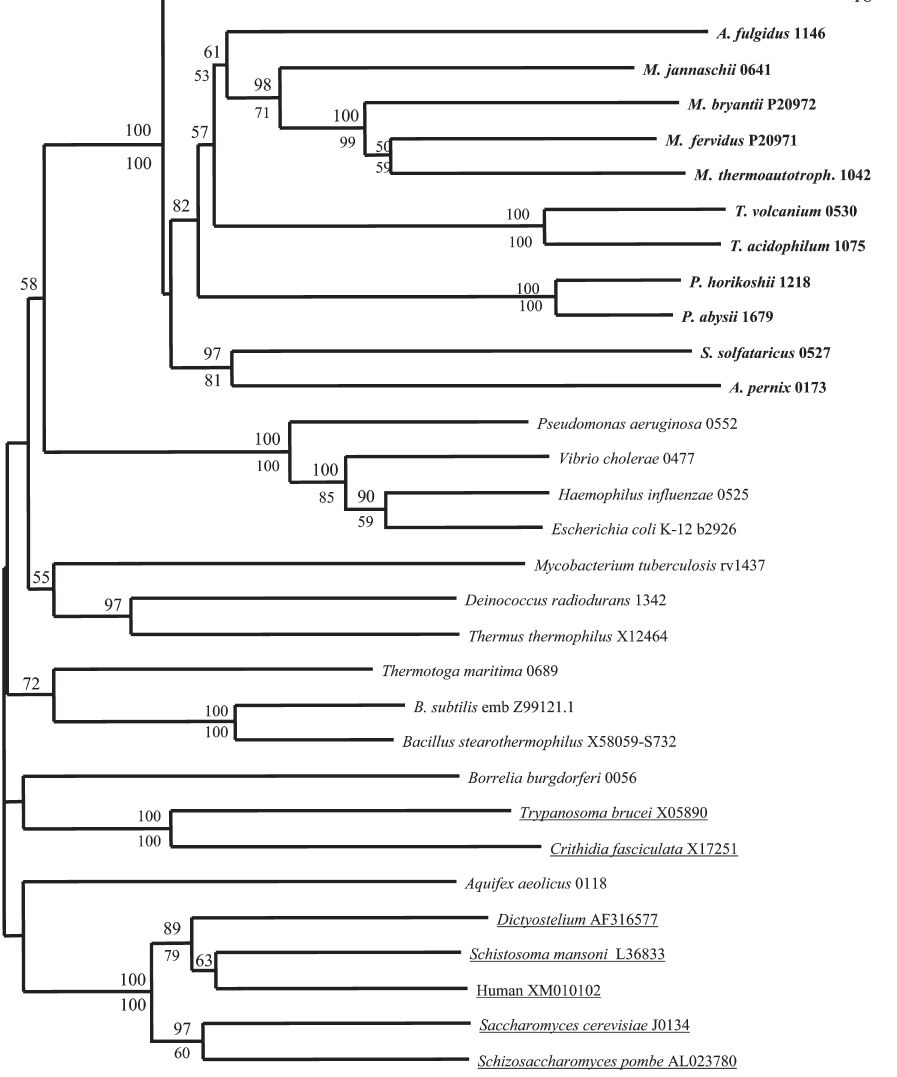
Figure 3. Phylogenetic tree of phosphoglycerate kinases (PGKs; EC 2.7.2.3) generated with the neighbor-joining method. The T. maritima PGK sequence used is based on Schurig et al. (1995 b ).